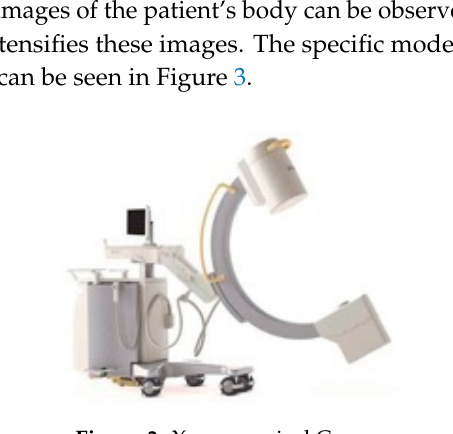
Figure 3. X-ray surgical C-arm.